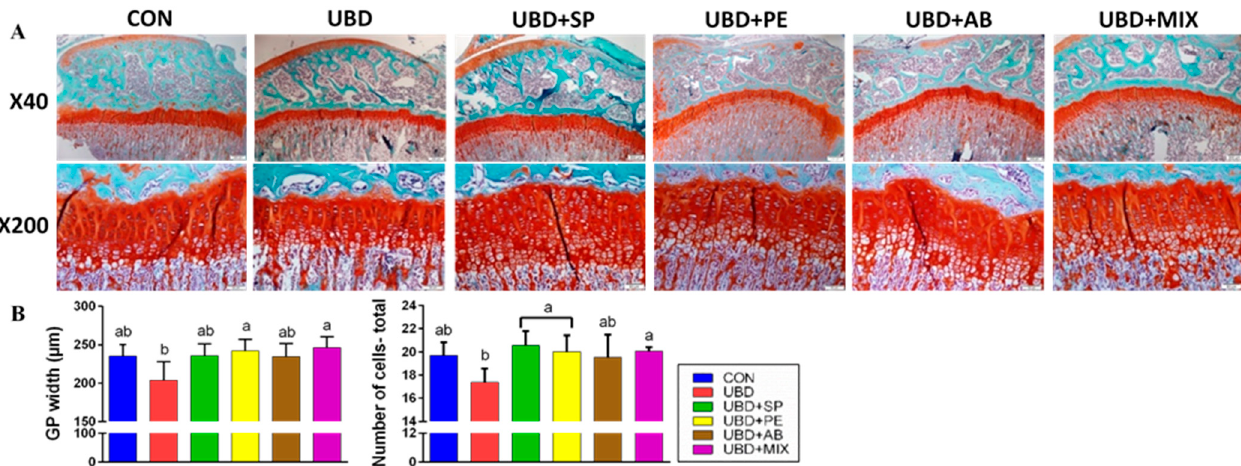
Figure 2. Histological evaluation of the tibial growth plates (GPs) of 9 weeks old rats. Transverse tissue sections of 5 μ m were prepared by microtome. GP width and number of cells has been measured in cell A software at 10 selected locations. ( A ) Safranin-O staining of the tibial GP . ( B ) GP width ( μ m); Number of cells. Values are expressed as mean ± SD of n = 5 rats/group, different superscript letters are significantly different ( p < 0.05) by one-way ANOVA followed by Tukey’s test.